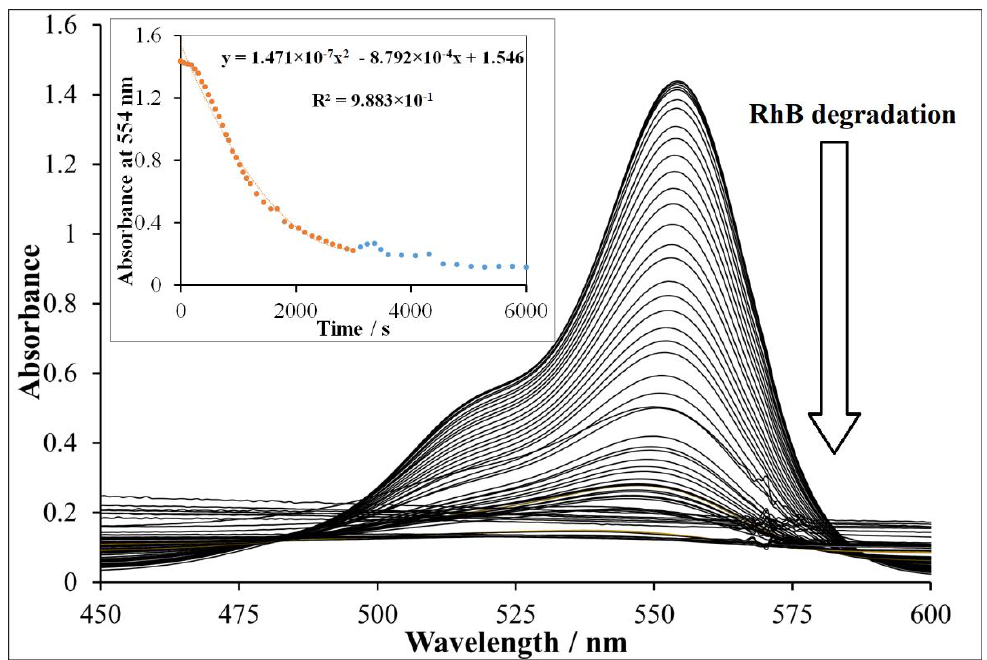
Figure 8. Rhodamine B degradation using Cu II O. Experimental conditions: concentration of RhB = 1.75 × 10 −5 mol/L, concentration of Cu II O = 400 mg/L, concentration of H 2 O 2 = 1.76 × 10 −1 mol/L, and initial pH = 7.5.